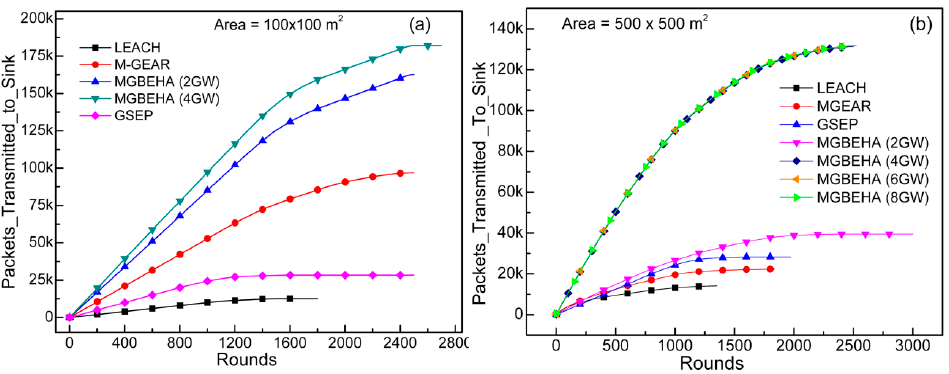
Figure 7. Total packets sent towards the sink in different protocols for ( a ) 100 m × 100 m, and ( b ) 500 m × 500 m area.